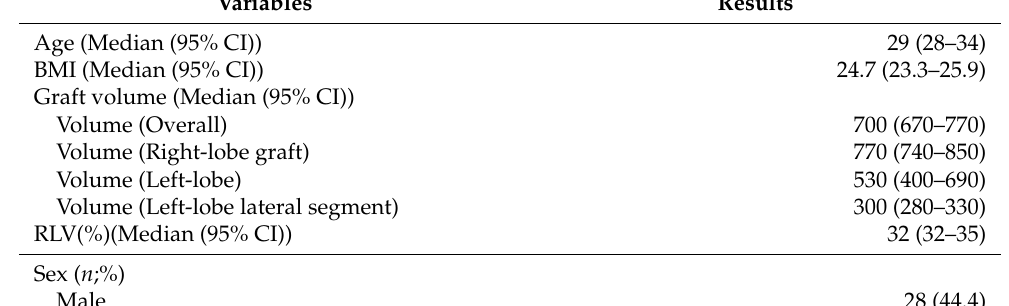
Table 1. Demographic and some clinical data of the LLDs included in the study group. Variables